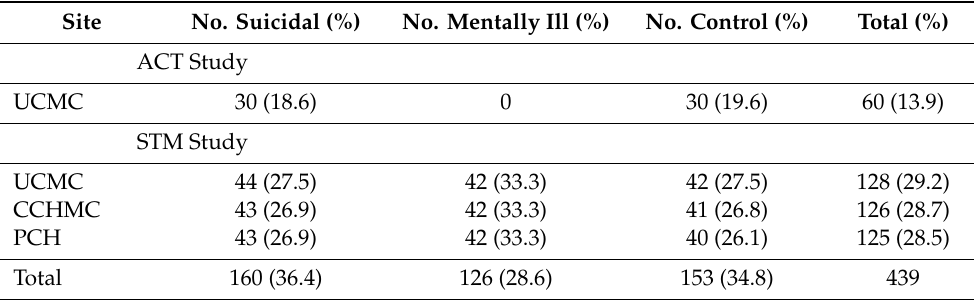
Table 1. Summary of machine learning model training data.